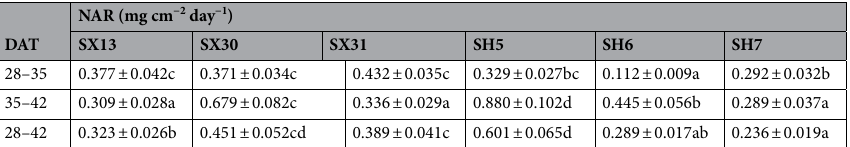
Table 3. The NAR of D. sophia subpopulations from Henan and Xinjiang under monoculture condition. Different lowercase indicated significant difference with p <0.05.